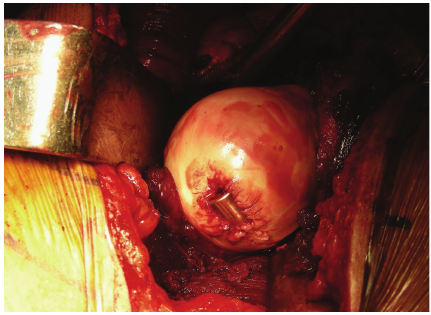
Figure 3: Intraoperative picture showing the presence of the bullet in the femoral head.